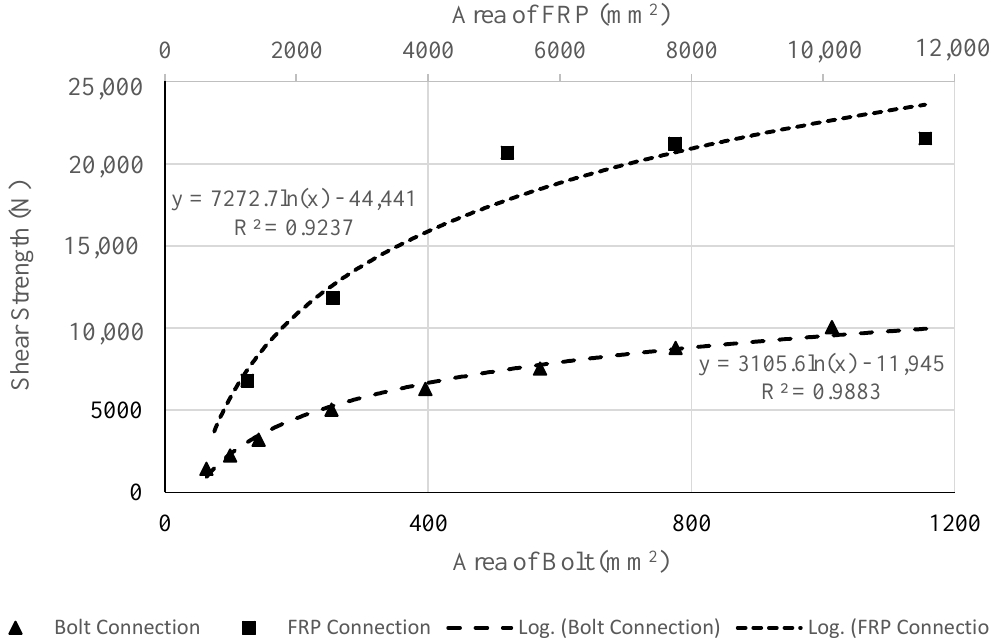
Figure 18 represents comparison of regression models for GFRP tie and bolted connec- tion since they are both double lap shear tests.